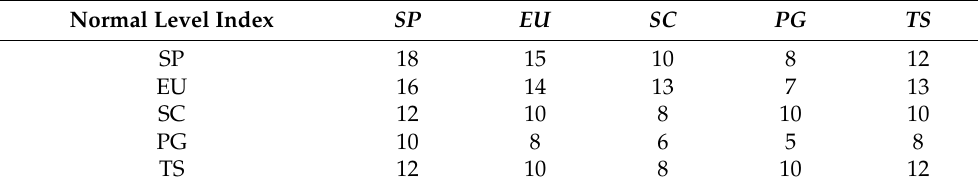
Table 2. We form an indicator table according to the interrelationship between the elements, which were pairwise compared. The index interrelationship of the evaluation index system criterion layer is as follows.